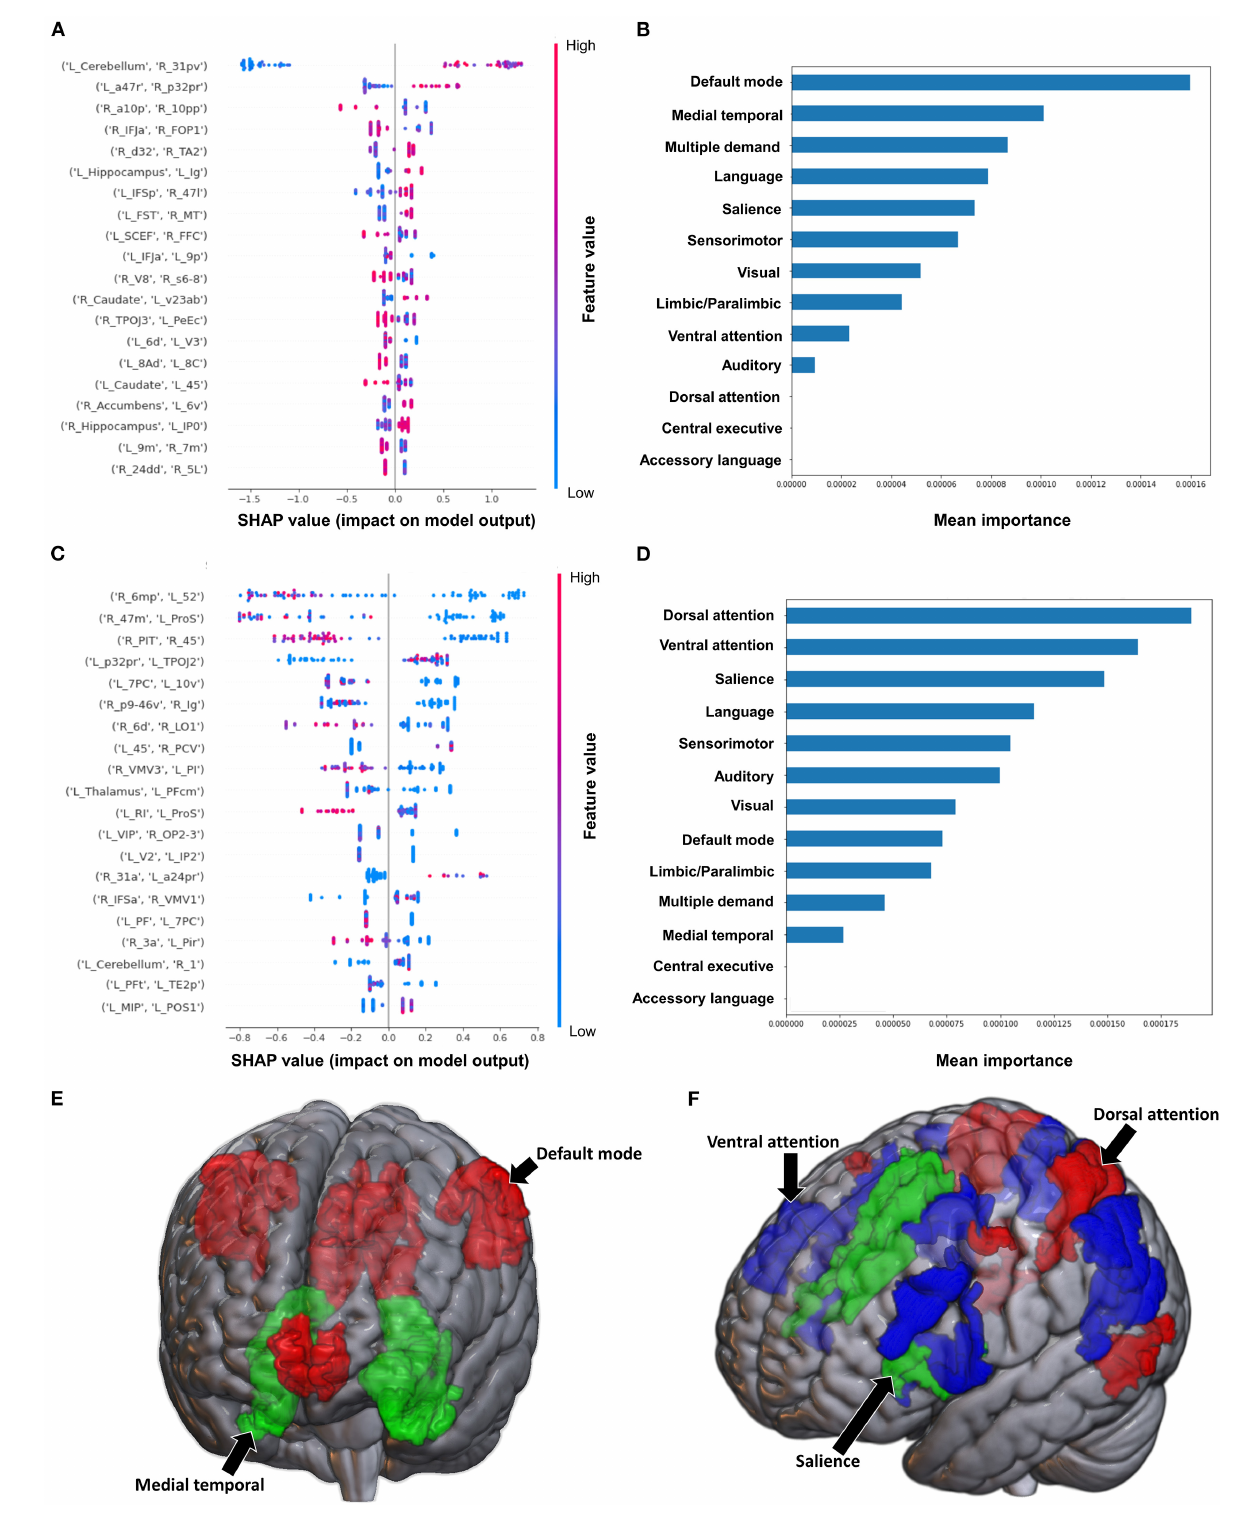
FIGURE5 Feature Importance Analysis of the models classifying the modified Ashworth scale—upper extremity based on functional connectivity at the (A) individual brain region level, and (B) the network level; and based on structural connectivity at the (C) the individual brain region level, and (D) the network level. The networks contributing most to the models’ classifications, based on (E) functional connectivity, and (F) structural connectivity, have also been visualized on brain